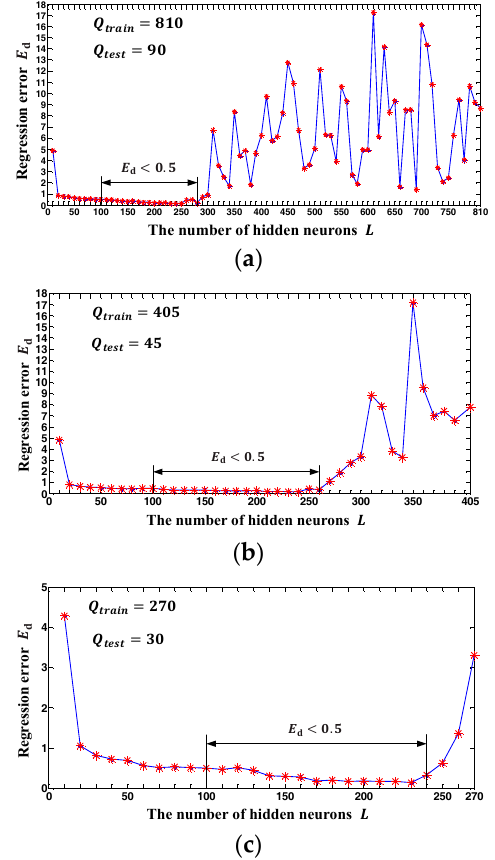
Figure 7. The variation tendency of regression error E d with respect to the equal increase of L . ( a ) The number of sample is 900. ( b ) The number of sample is 450. ( c ) The number of sample is 300.